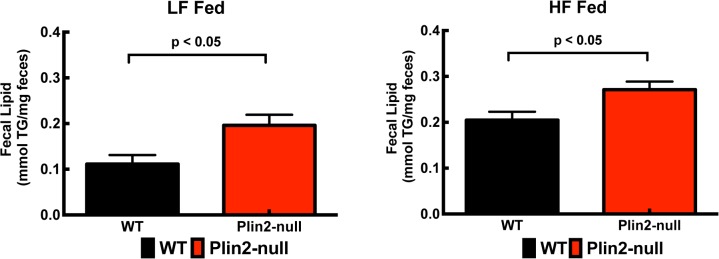
Effects of LF and HF diet feeding on fecal lipid contents.Fecal lipid quantities for WT and Plin2-null mice fed LF (A) or HF (B) diets for four days. All values are means ± SD, N = 4 per group. P-values were determined using the unpaired t-test (Prism 6, GraphPad Prism).